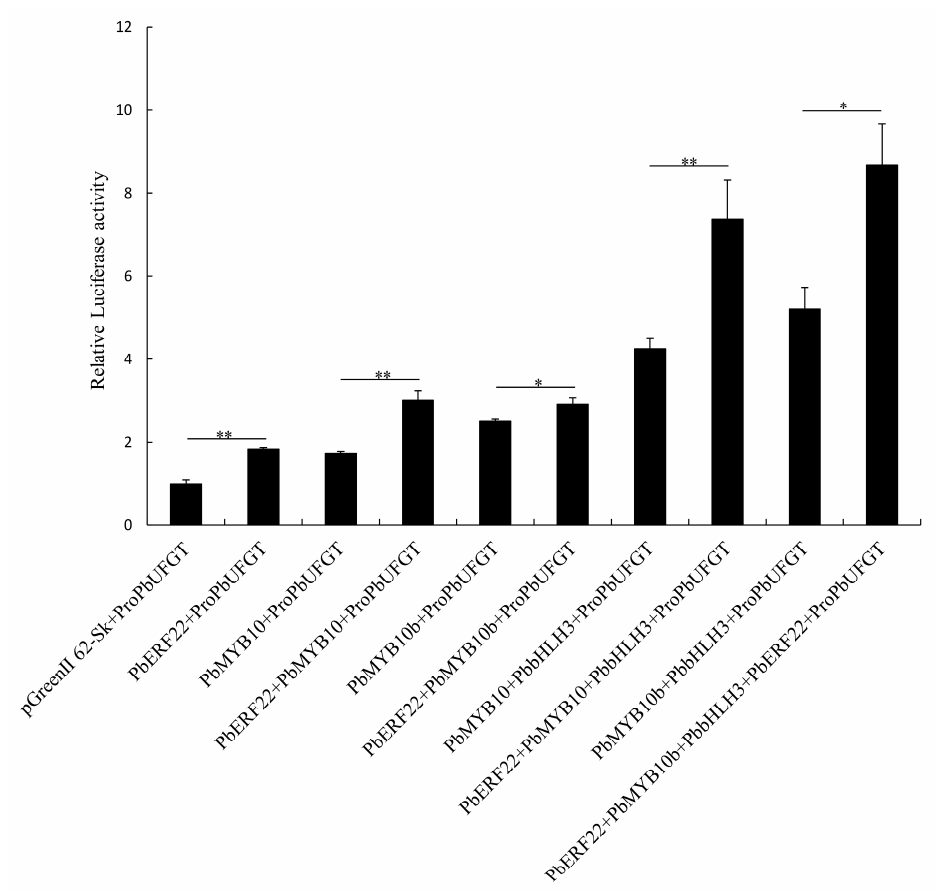
Figure6. Dualluciferase(LUC)assayverifyingthat PbMYB10 , PbMYB10b , and PbbHLH3 co-transformed Figure 6. Dual luciferase (LUC) assay verifying that PbMYB10 , PbMYB10b , and PbbHLH3 co-transformed with PbERF22 increased the PbUFGT promoter activity. The PbUFGT promoter with PbERF22 increased the PbUFGT promoter activity. The PbUFGT promoter activity is expressed activity is expressed as a ratio of LUC to Renilla (REN) activities. * indicates significant differences at as a ratio of LUC to Renilla (REN) activities. * indicates significant di ff erences at p < 0.05, ** indicates p < 0.05, ** indicates significant differences at p < 0.01. Data are means ± SEs of three biological replicates.